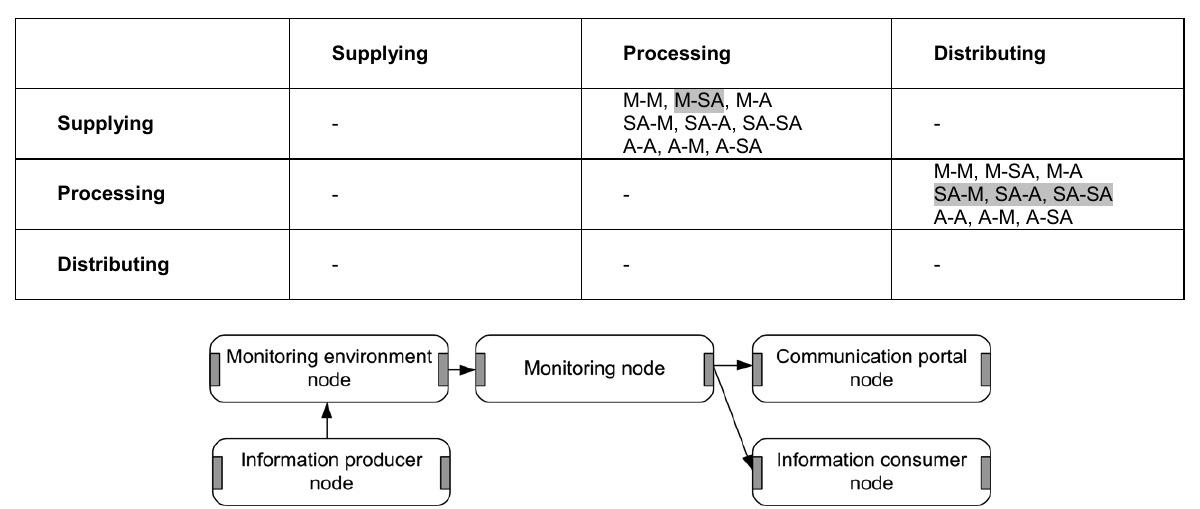
Table 2. Monitoring node configuration options. (Rows - information transmitted from; columns